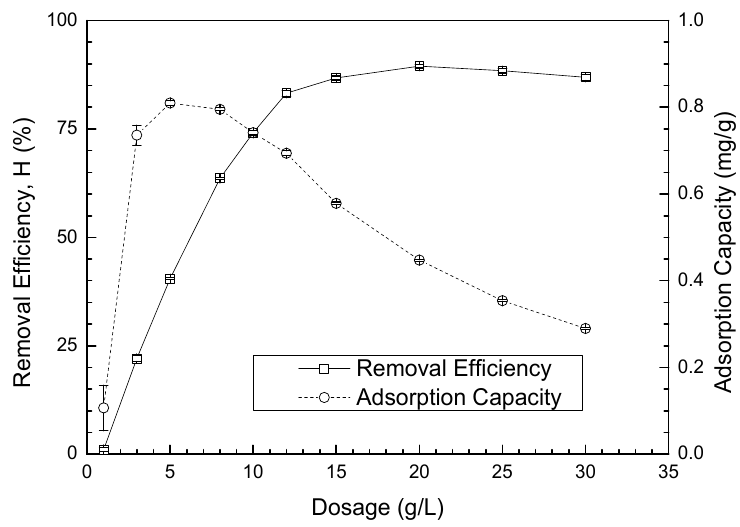
Figure 5. Impact of UBC dosage on adsorption of RB5 on